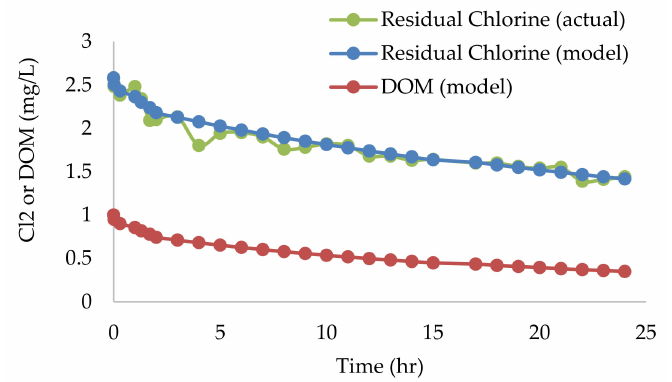
Figure A2. Reduction in chlorine and